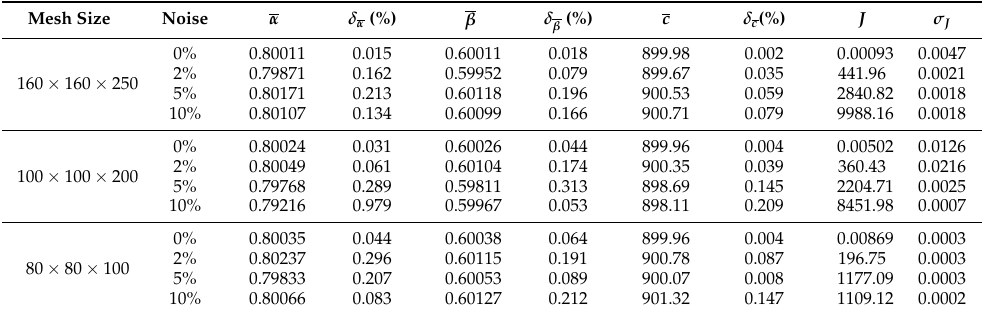
Table 3. Results of the calculations in the case of twelve measurements points P i ( i = 1,2, . . . ,12): α i — reconstructed value of x -directional order derivative α , β —reconstructed value of y -directional order i derivative β , c —reconstructed value of parameter c , δ —relative error of reconstruction, J —value of the objective function, σ —standard deviation of the objective function.